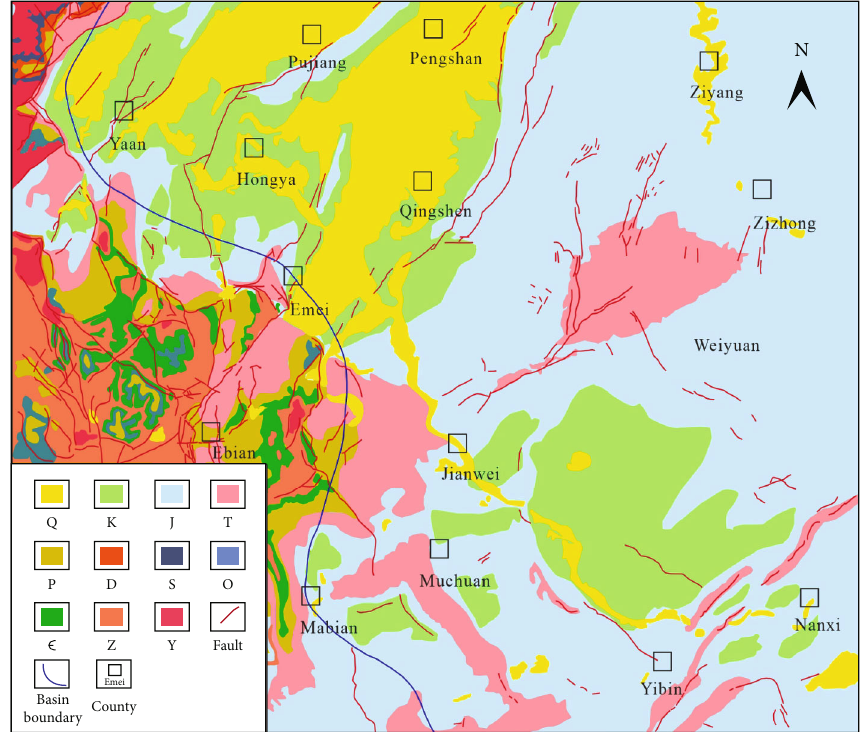
Figure 6: Outcrops in the southwestern Sichuan